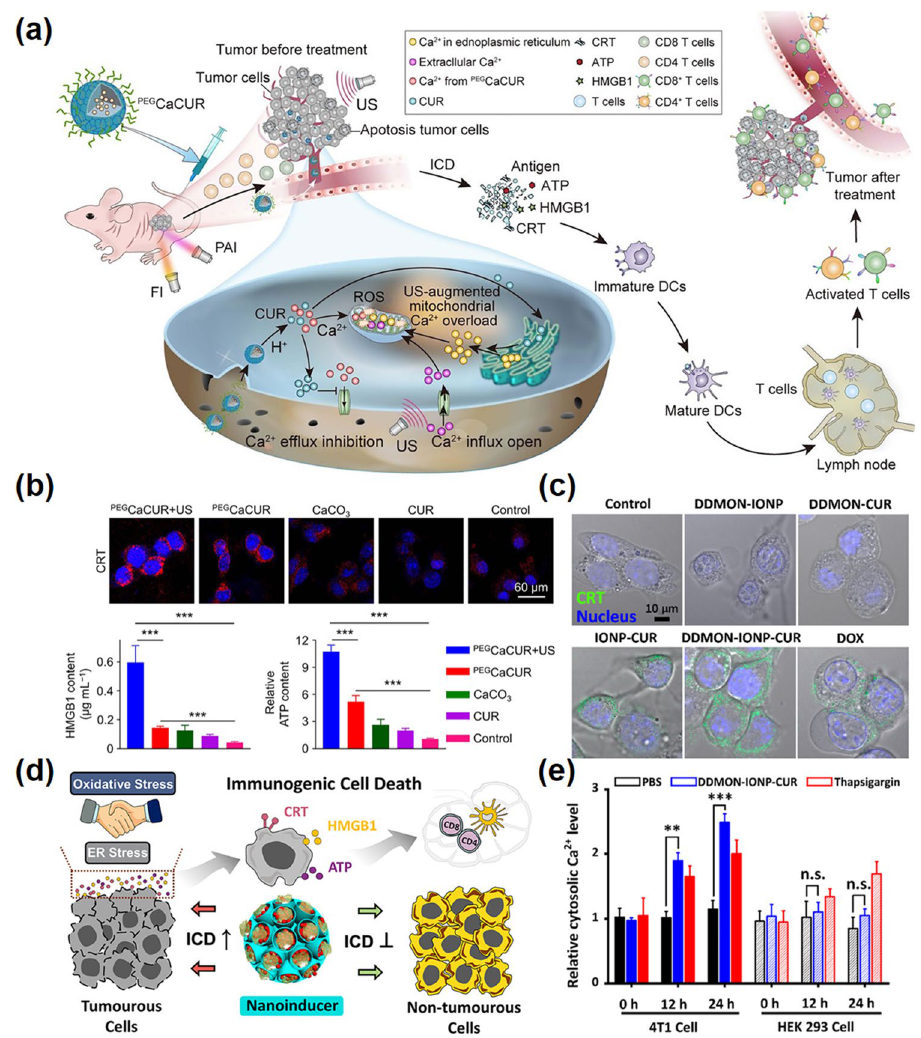
Fig. 10 Ca-NMs-induced immunogenic cell death. a Schematic diagram of collaborative cancer therapy based on PA/FI imaging-guided ultra- sound enhanced PEG CaCUR-induced mitochondrial Ca 2+ overload. b CRT exposure (top panel) and the release of HMGB1 and ATP (low